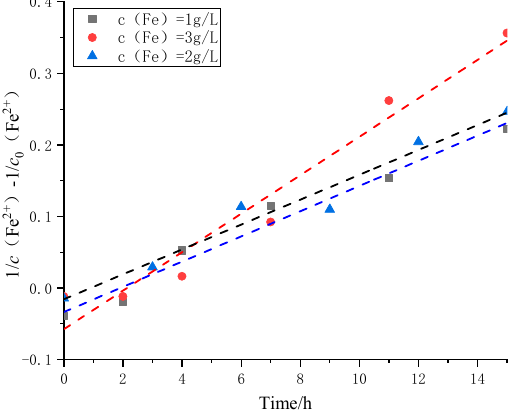
Figure 11. Second-order kinetics fitting of ferrous oxidation reaction. Table 2. Kinetic equation and rate constant.